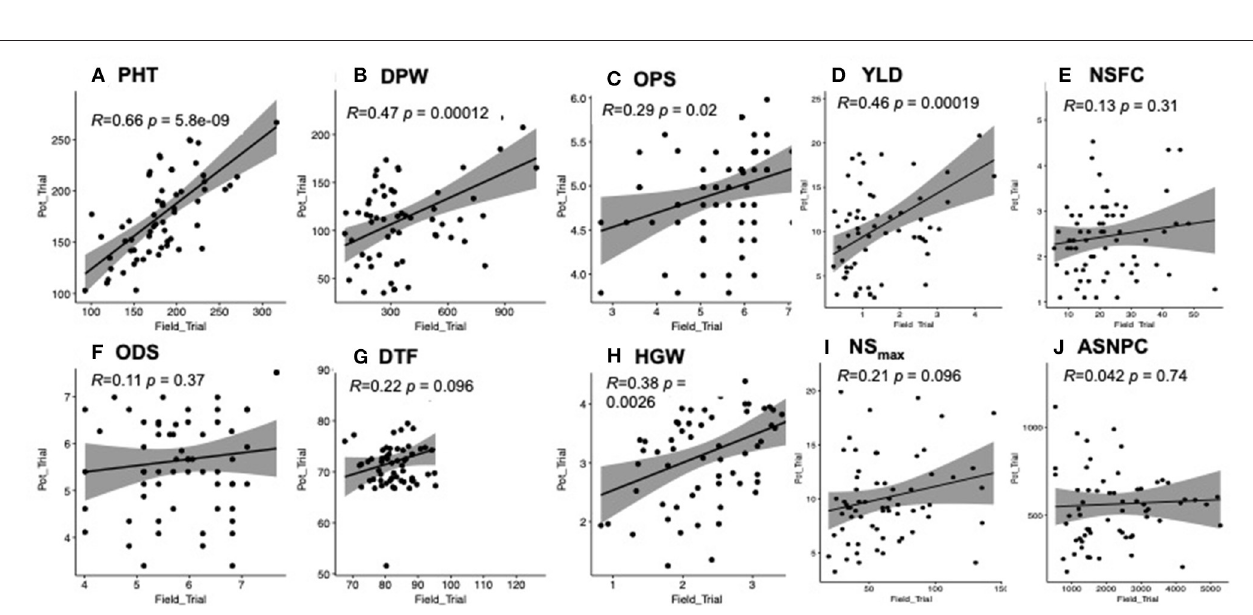
FIGURE 2 | (A-J) Correlation of traits between field and pot trials. Significant correlations were observed for plant height (PH), dry panicle weight (DPW), overall pest score (OPS), yield (YLD), and 100-grain weight (HGW) at P < 0.05.